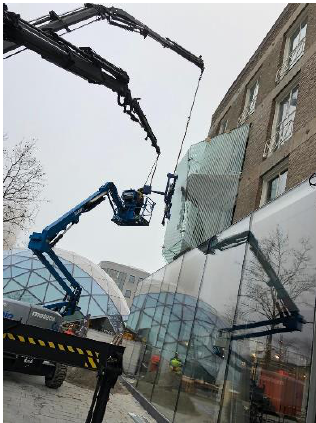
Fig. 17 installation of front panel. Fig. 18 installation of front